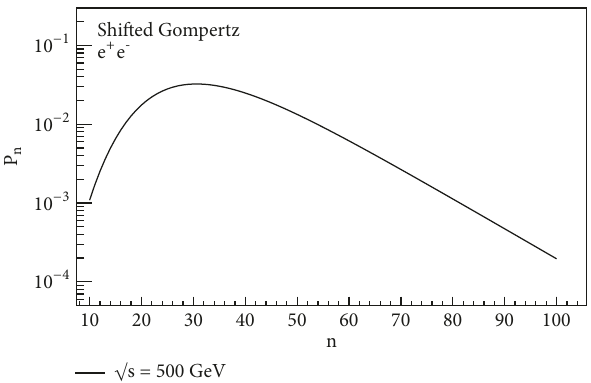
Figure 10: Probability distribution for 𝑒 + 𝑒 − collisions predicted from shifted Gompertz function.